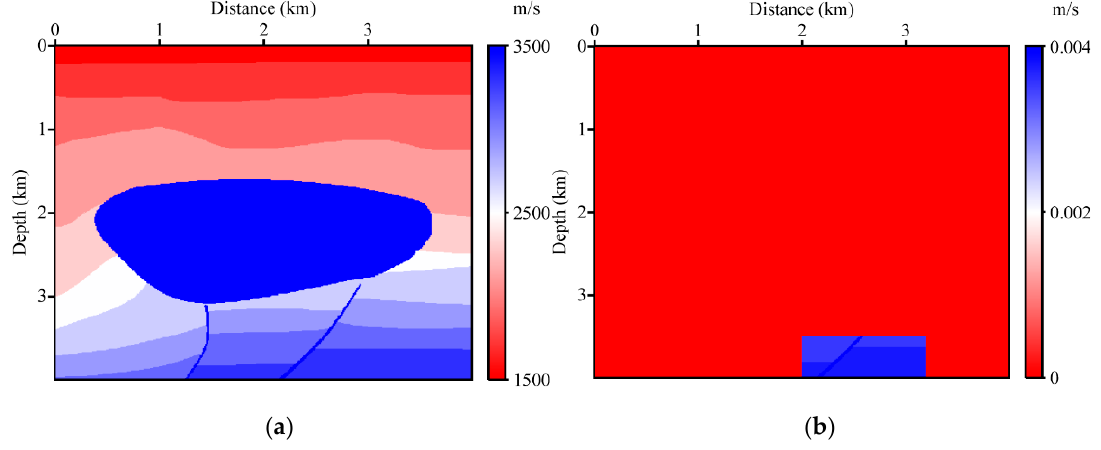
Figure 10. Migration model: ( a ) True P-wave velocity; ( b ) Stained target.